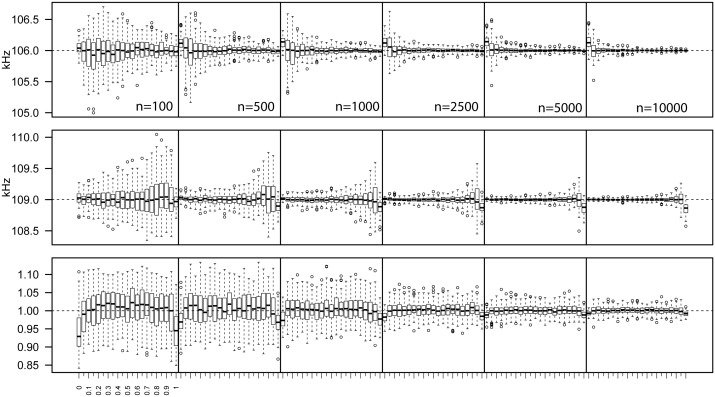
Mean peak frequency of males (top) and females (middle) and the within-sex (equal for males and females) standard deviation of calls (bottom).Estimated via ABC for the same datasets as in Fig 2, but plotted separately for the six different sample sizes (represented by blocks).